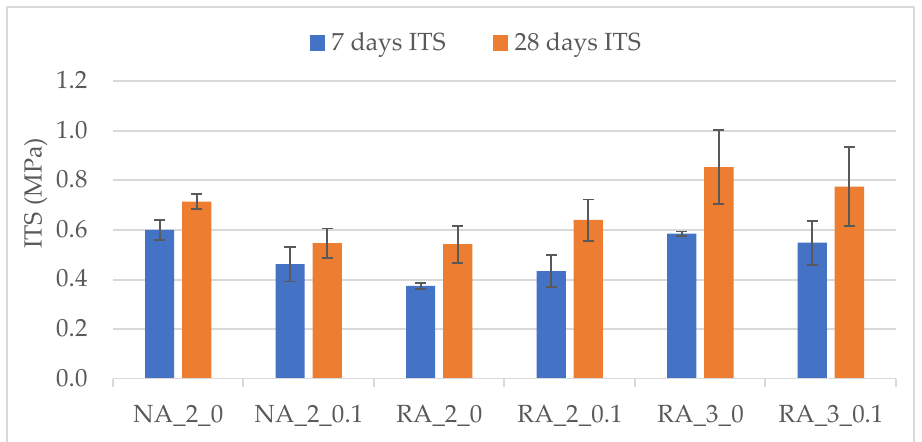
Figure 4. Indirect tensile strength of the CBGMs at 7 and 28 days of curing.